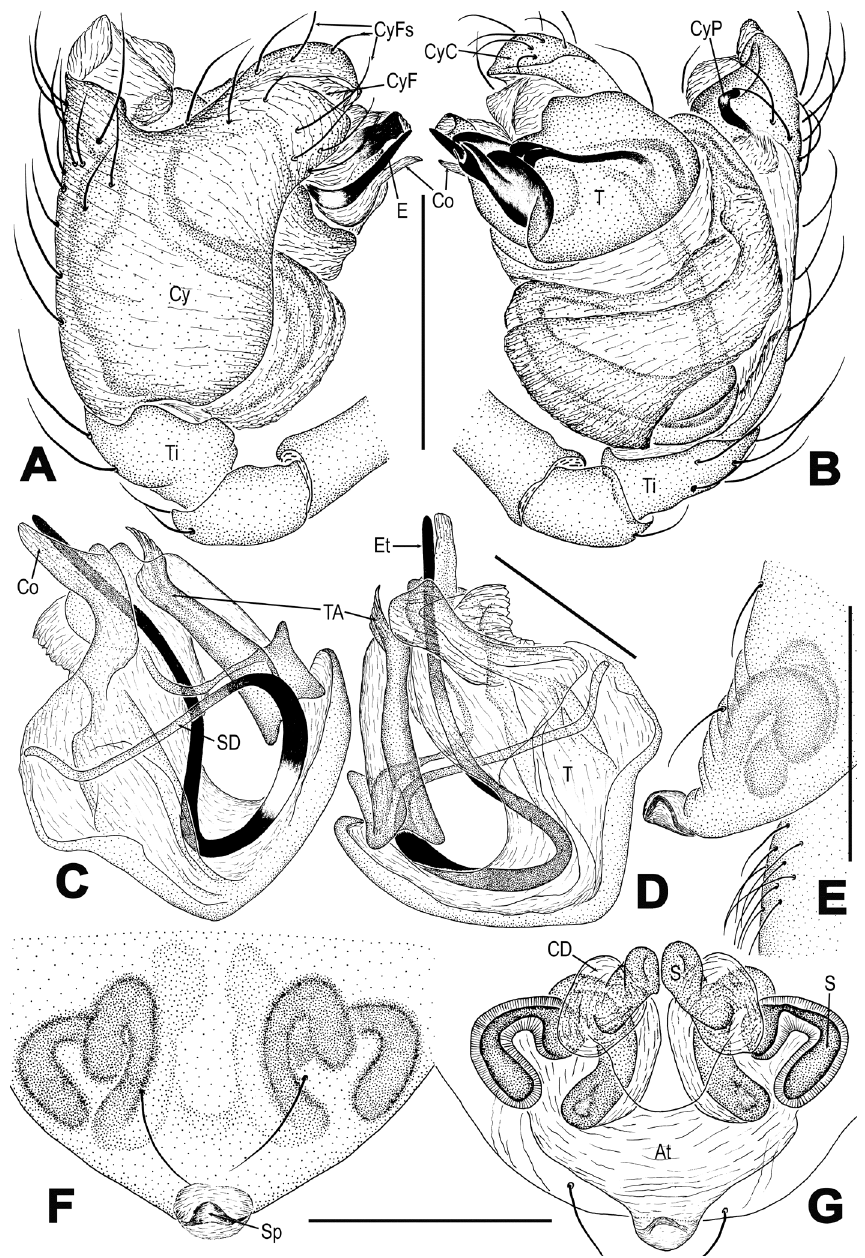
Figure 3. Trogloneta speciosum Lin & Li, 2008, male ( A–D ) and female ( E–G ). A, B Left palp C, D Embolic division E, F Epigyne G Vulva. A prolateral B retrolateral C, G dorsal D, F ventral E lateral. Abbreviations: At atrium; CD copulatory ducts; CO copulatory opening; Co conductor; Cy cymbium; CyC cymbial conductor; CyF cymbial fold; CyFs setae on cymbial fold; CyP cymbial process; E embolus; Et embolic tip; S spermathecae, SD spermatic duct; Sp scape; T tegulum, TA tegular apophysis; Ti tibia. Scale bars: 0.20 mm ( A, B, E–G ) ; 0.10 mm ( C, D )